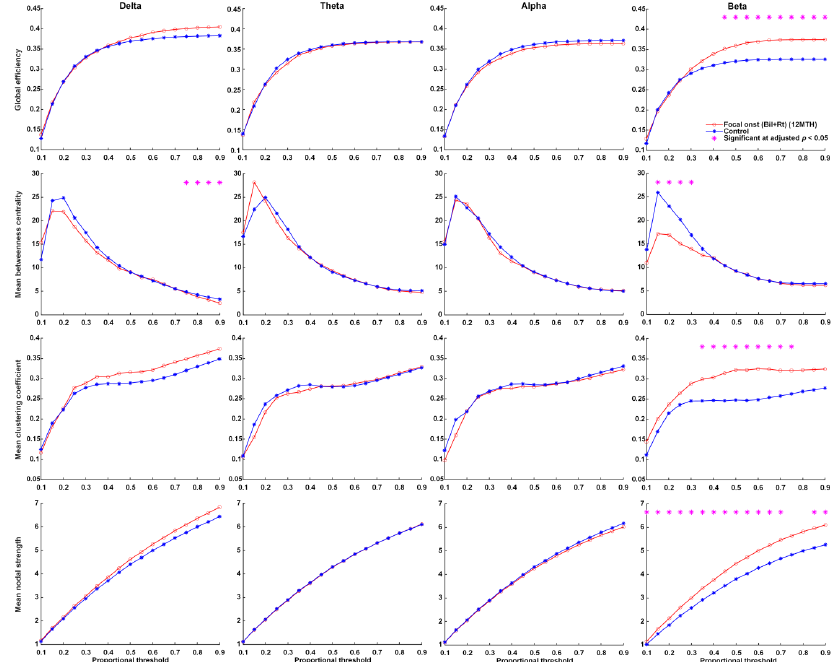
Figure 2. Parameters related to graph theory-based electroencephalographic connectivity in patients presenting FOS with right or bilateral EEG lateralization after 12 months of KDT and age-matched controls. Asterisks denote statistically significant differences (* adjusted p <